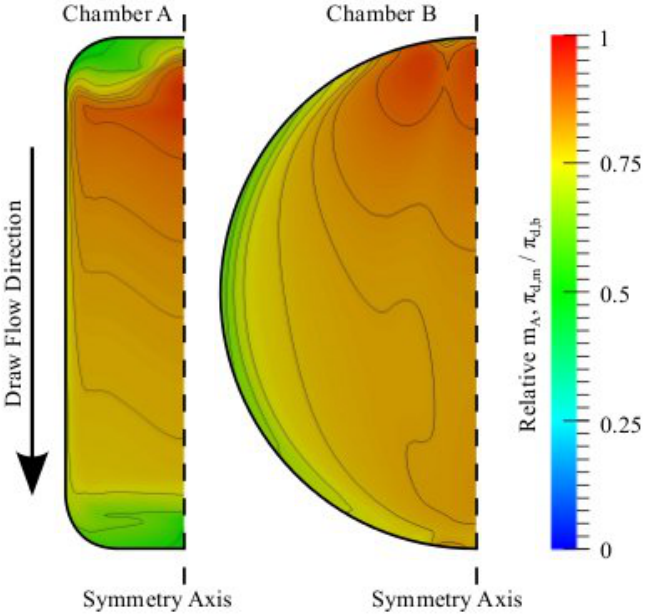
Figure 5. ECP maps on the draw solution side of the membrane for chambers A and B. The membrane concentrations are scaled relative to the bulk draw solution concentration, i.e ., the concentration at the inlet. The flow direction indicates that the inlets of both chambers are at the top of the figure, and correspondingly the outlets are at the bottom (see chambers in Figure 1). Both simulations were performed with 1 M draw solutions, pure water feed solutions and a 50 mL min − 1 cross-flow. Contour lines are shown for arbitrary scalars merely to guide the